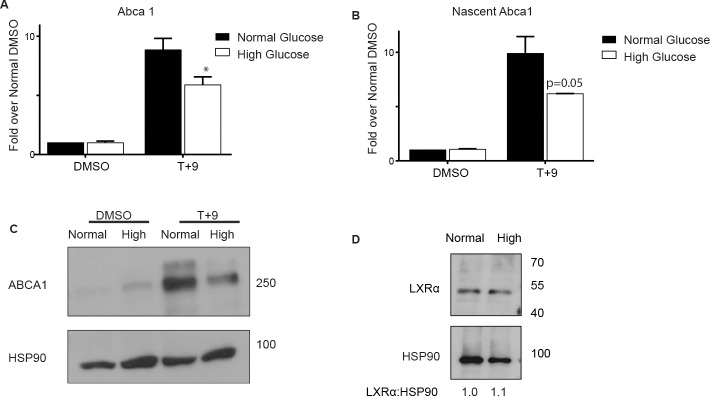
High glucose inhibits induction of Abca1 in BMDMs.Bone marrow cells from C57BL/6 mice were differentiated into macrophages under high (25 mM D-glucose) or normal (5.5 mM D-glucose + 19.5 mM L-glucose) glucose. Prior to treatments, macrophages were cultured in 1% FBS overnight and then treated for four hours with 5 μM T + 1 μM 9cisRA (T+9) or DMSO vehicle control and steady state RNA (A) and nascent RNA (B) transcripts of Abca1 were profiled using qRT-PCR. Cyclophilin A was used for normalization. (C) BMDMs were cultured and treated as in A for eight hours. Whole cell protein extracts were collected and separated on a 7.5% polyacrylamide gel and were blotted for ABCA1. HSP90 was used as a loading control. (D) Whole cell protein extracts collected from untreated BMDMs cultured under high and normal glucose were separated as in (C) and blotted for LXRα. HSP90 was used as a loading control. The levels of LXRα and HSP90 protein were quantitated by densitometry and presented below with normal glucose set to 1. The ratio of panels A and B represent an average of three independent experiments. Error bars indicate the SEM. Significance is determined using the two-tailed Student's t-test (*, P < 0.05, **, P<0.01, ***, P<0.001). (C) and (D) are representative.